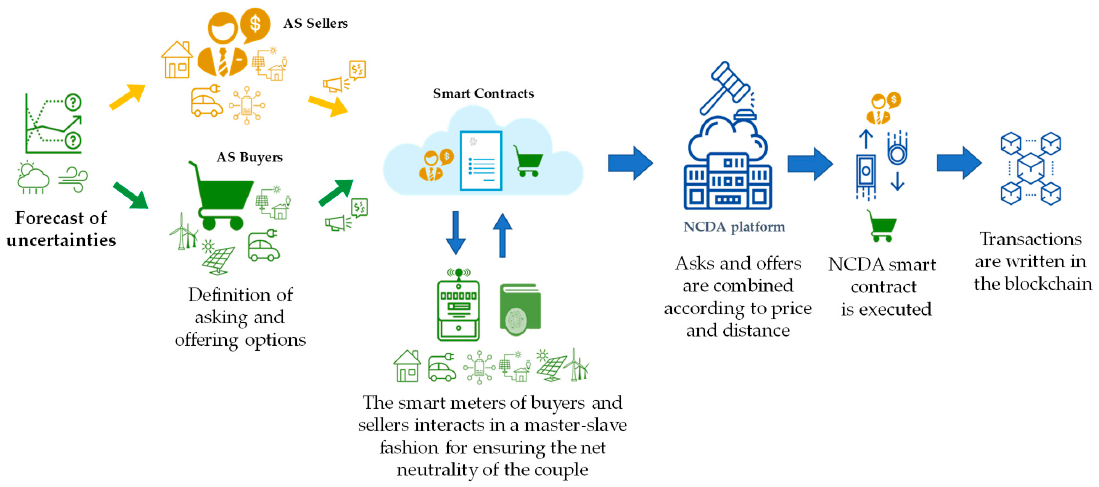
Figure 1. Working scheme of the VDMA